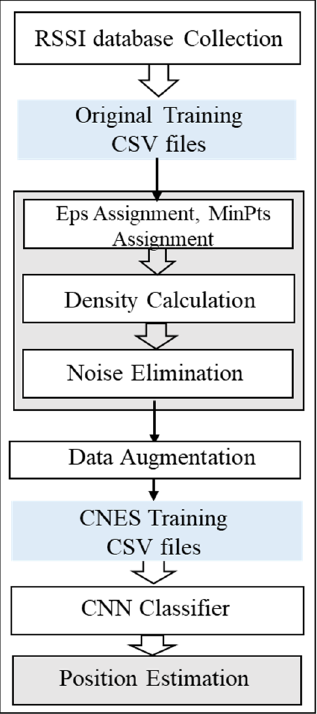
Figure 9. The effect of CNES corresponding to eps = 70 and MinPts = 4 on total number of RSSI samples at each RP.